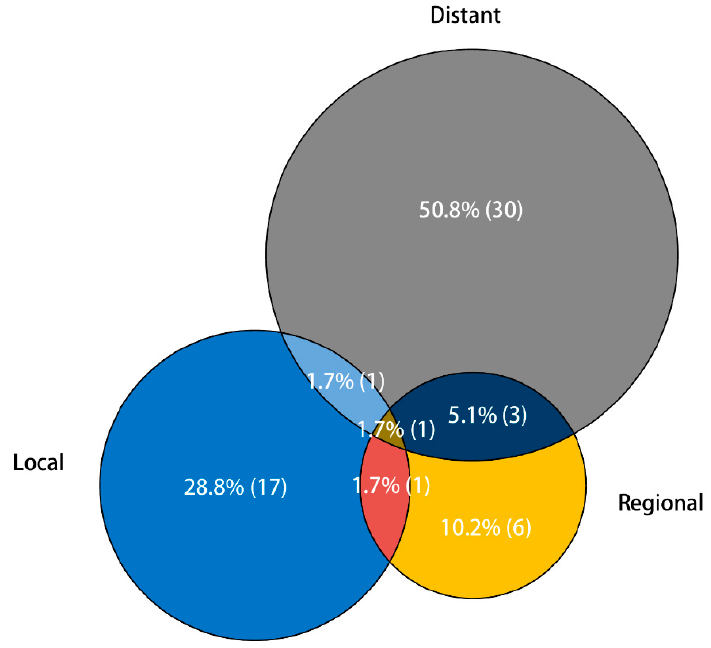
Figure 6. Patterns of Figure 6. Pa tt erns of failure.